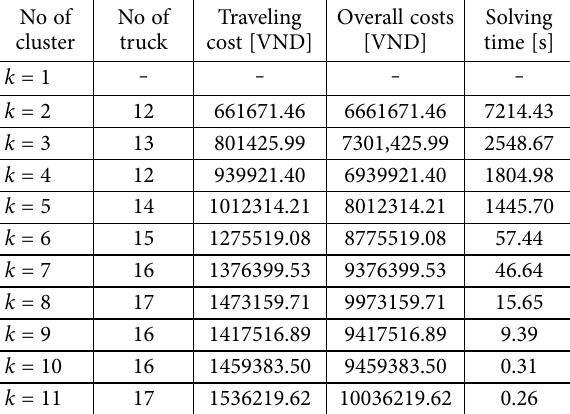
Table 6. An example demand set for problems have 9 customers (source: current study)